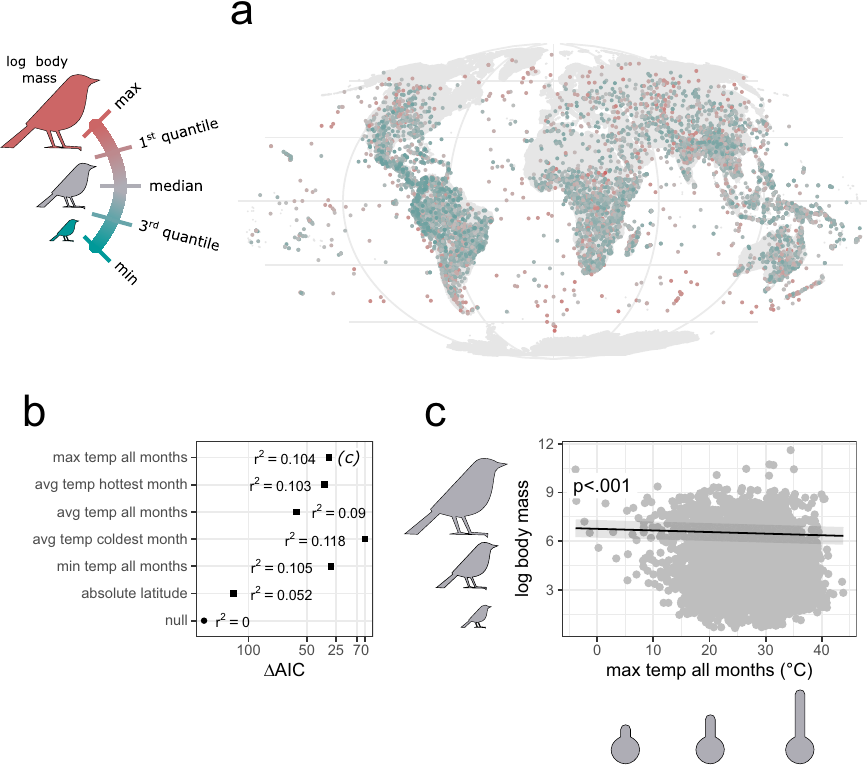
Fig. 1 | Global test of Bergmann ’ s rule across 9962 (99.7%) avian species. Dis- tributionoflog-transformedbodymassacrossspeciesgeographicranges,shownas their geometric centroids ( a ). Model selection procedure for predicting log body mass( b ),withsixtemperaturemeasuresassessedwithinspeciesgeographicranges, as sole fi xed effects; AIC — Akaike Information Criterion, r 2 — coef fi cient of determi- nation. An exemplar Bergmann ’ s model( c ), showing decreasing body size with max